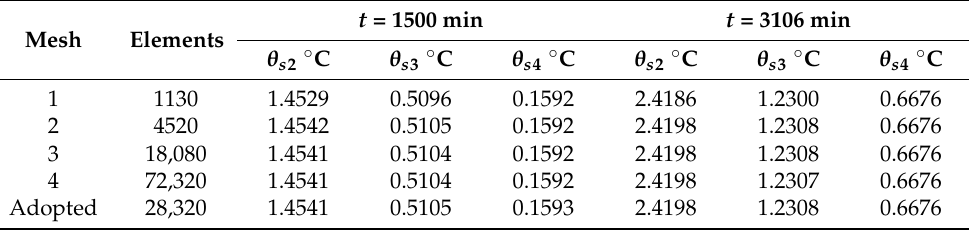
Table 2. Preliminary estimate of α s : values of θ s 2 , θ s 3 , and θ s 4 at selected instants of time, obtained by different